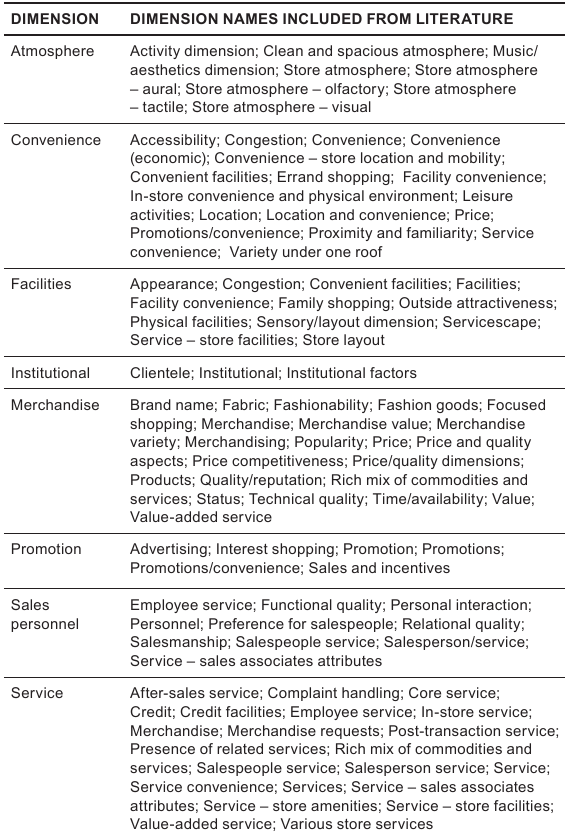
TABLe 1 Store image dimensions identified from the